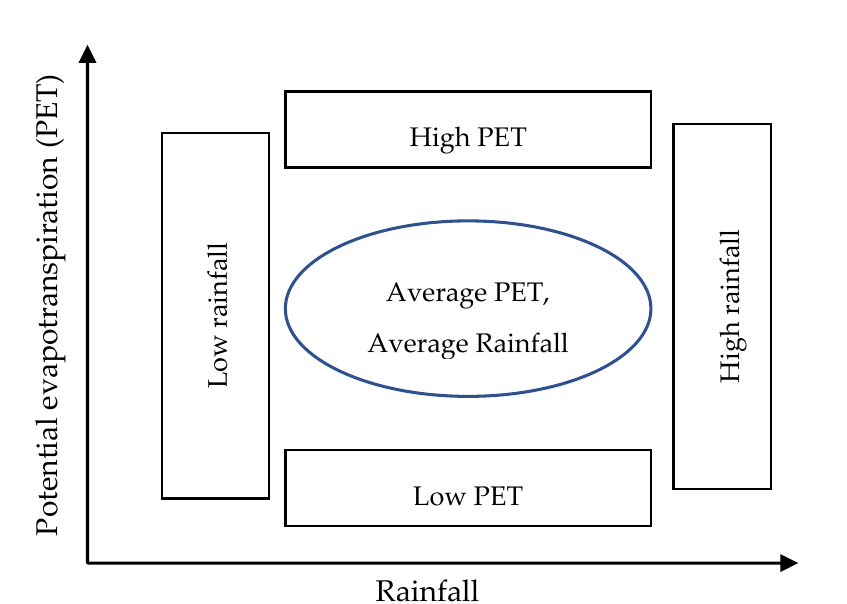
Figure 4. Conceptual diagram of selecting five future climate scenarios by combining the low, medium and high PET with low, average and high rainfall.